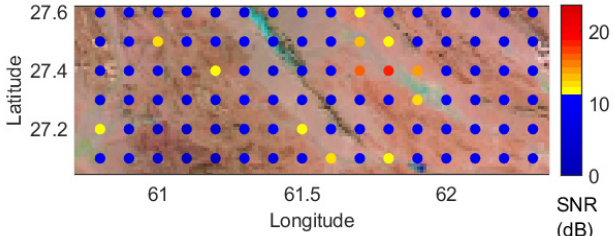
Figure 13. The georeferenced optical satellite imagery of the flood over the cities of Zaboli and Suran (region C in Figure 10) from MODIS (13 January 2020) overlaid by the corrected SNR derived from CYGNSS observations (13 January to 15 January 2020). The region includes a river and an inland water body.